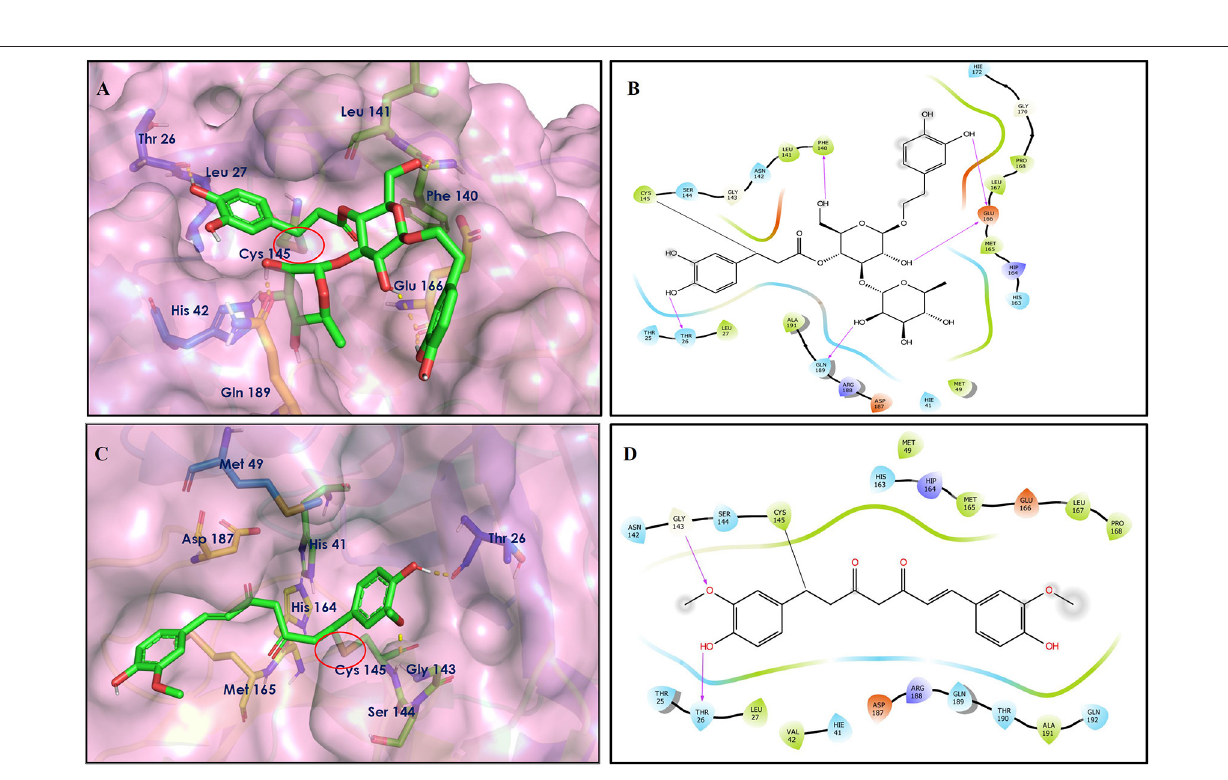
Frontiers in Molecular Biosciences |